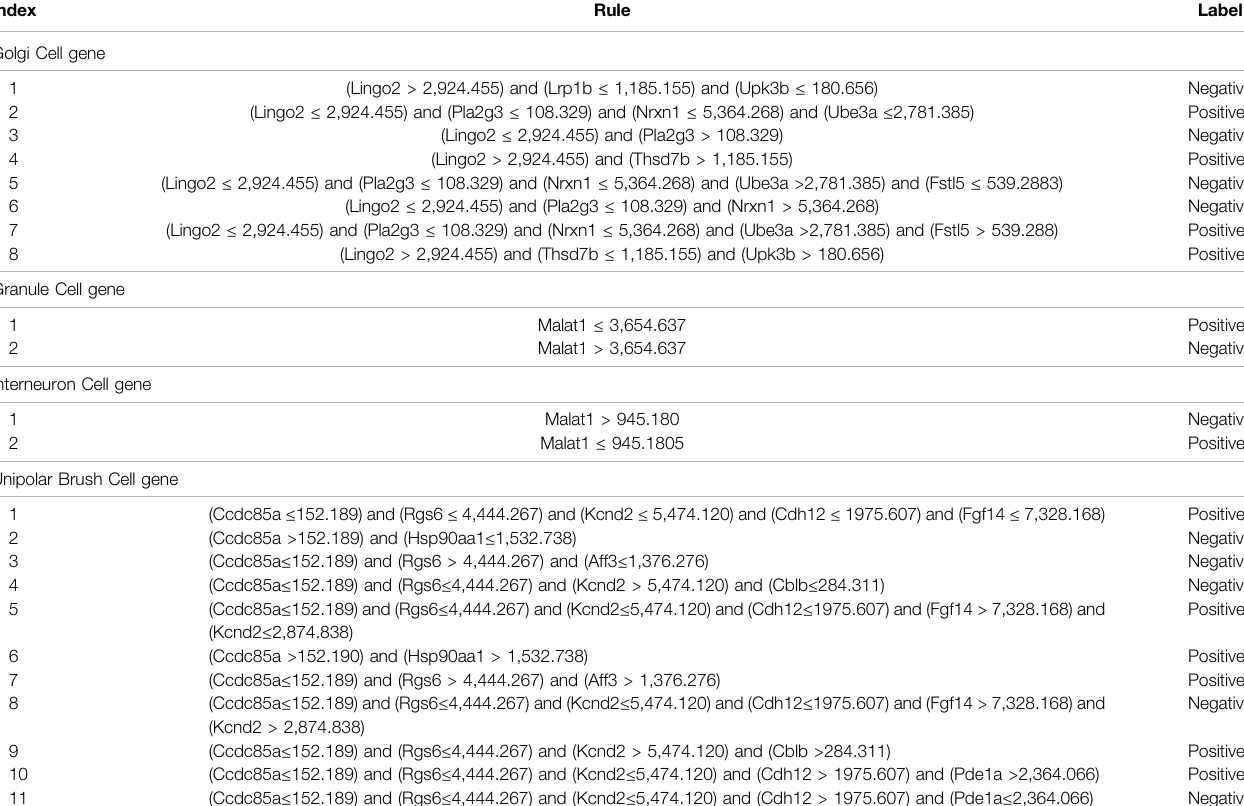
TABLE 4 | Classi fi cation rules generated by